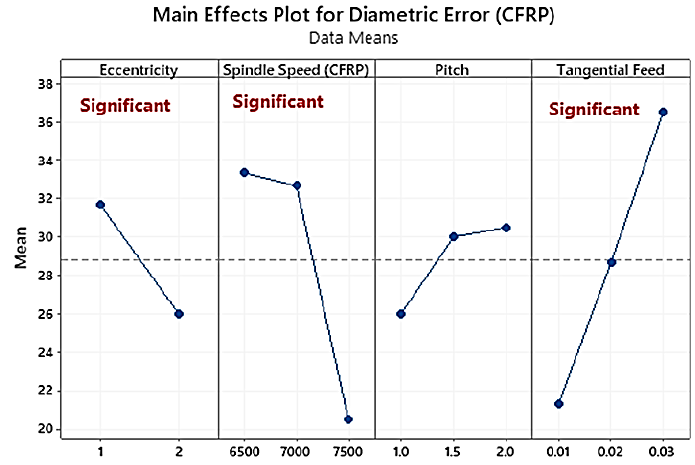
Figure 4. Main effects plot of diametric error in hole-making of CFRP. Table 3. Analysis of variance of diametric error of CFRP.